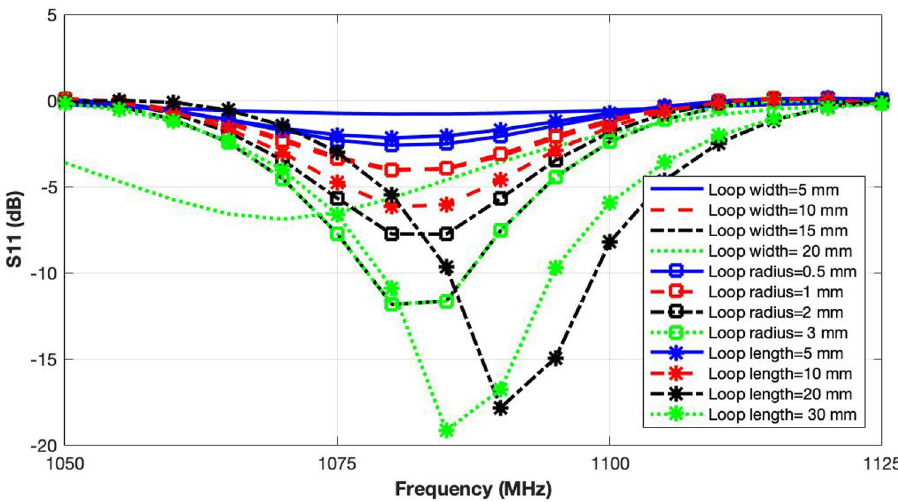
Figure 4. Re-tuning the loaded cavity exposure system by changing coupling loop dimensions.